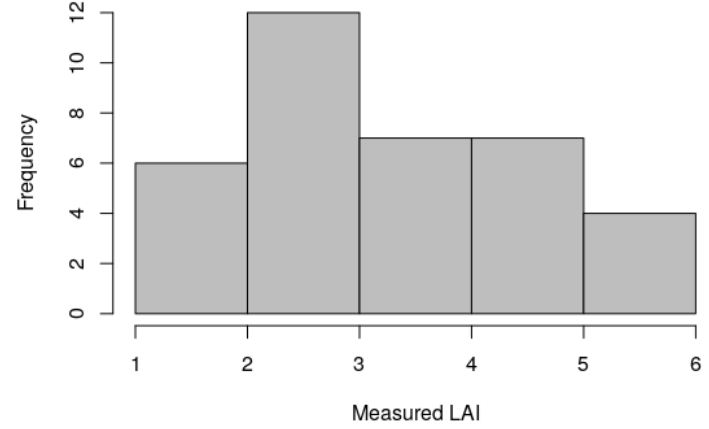
Figure 2. Distribution of in situ-measured e ff ective leaf area index (LAI e ).